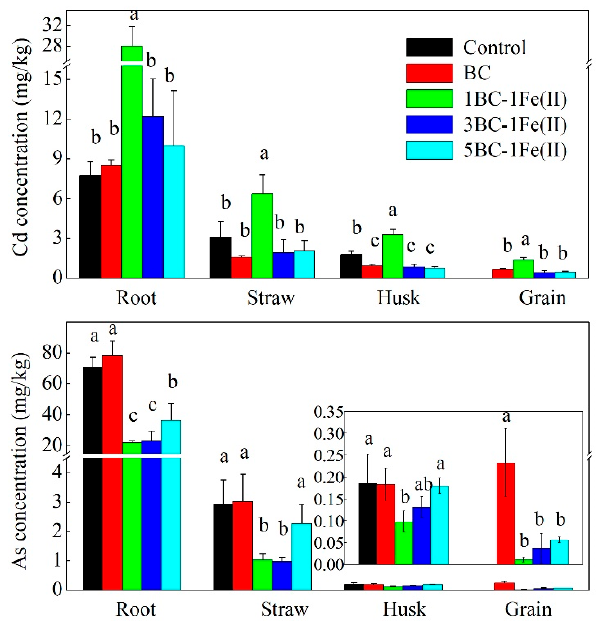
Figure 4. The Cd and As contents in rice tissues. The un-amendment soil (Control) inhibited the ear formation of rice (grain is null in control treatment). Different letters indicate that the differences are statistically significant ( p < 0.05). The data are mean ± standard error ( n = 3), bars represent standard errors ( n = 3). Control, untreated soil; BC, applied 1% (w/w) biochar; 1BC-1Fe(II), applied 0.5% biochar and 0.5% ferrous sulfate; 3BC-1Fe(II), applied 0.75% biochar and 0.25% ferrous sulfate; 5BC-1Fe(II), applied 0.83% biochar, and 0.17% ferrous sulfate.